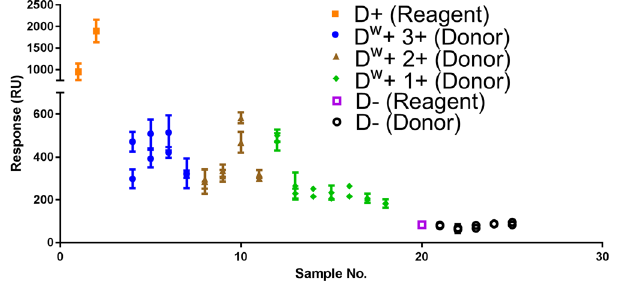
Figure 2. SPR detection of 15 weak D antigens on donor samples using anti-D IgG FFMU compared to 2 D-positive reagent cells, and 6 D-negative samples (1 reagent, 5 donor). Each sample was prepared twice, and each preparation was tested three times; the average and standard deviation are plotted. * Discontinuous Y-axis was used to better show the detection variance between weak D samples. RU measured after t = 900 s when the region 4 plateaux has reached